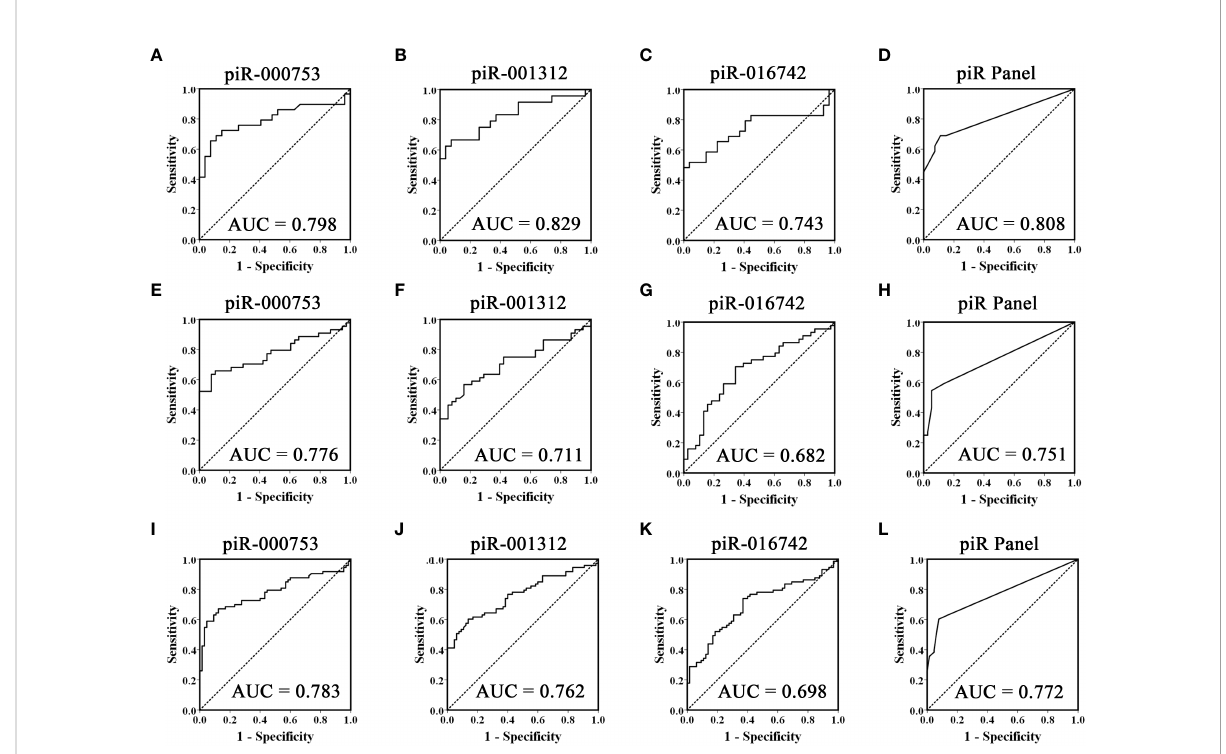
FIGURE 2 ROC curves analysis of the three selected piRNAs. Receiver operating characteristic (ROC) curves for the ability of three individual piRNAs and the three-piRNA panel to distinguish brucellosis patients from controls in the training set (A-D) , validation set (E-H) and the combined two sets (I-L)